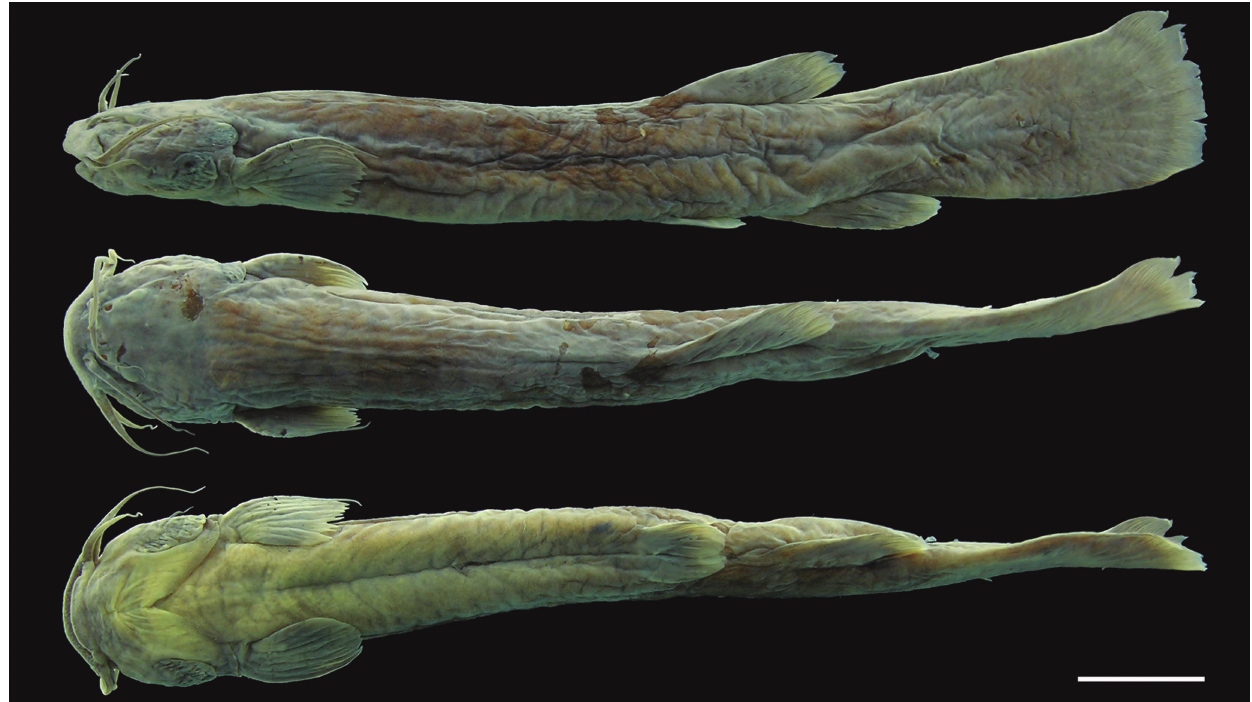
Fig. 5. Trichomycterus steindachneri , paratype, MBUCV-V-35652, 88.8 mm SL, Colombia, Cundinamarca, Ubaque, Vereda Pueblo Nuevo, quebrada El Charco, tributary of quebrada Santa Bárbara, río El Palmar system, río Orinoco basin. 04°31’10.3”N 73°58’44.6”W, 2700 m. Scale bar = 1